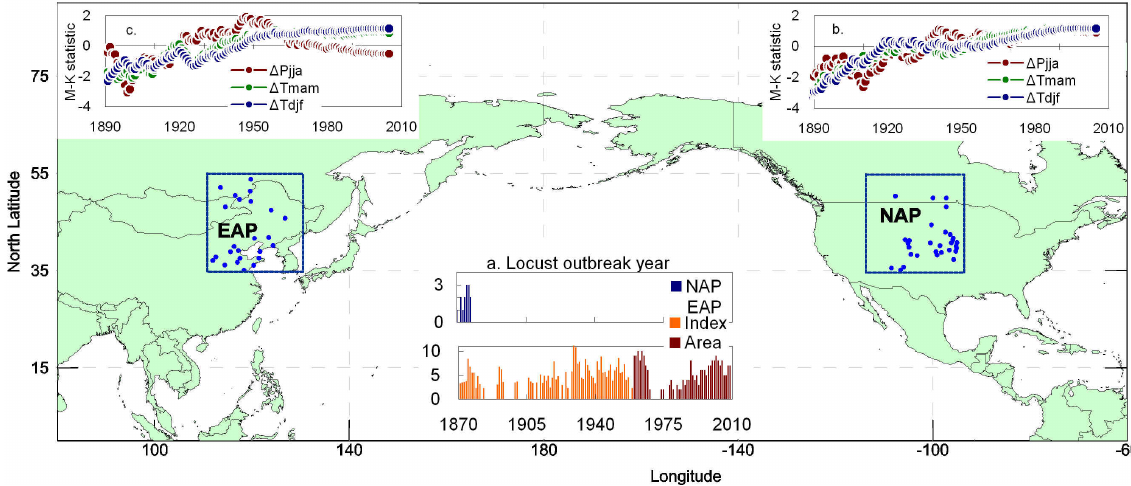
Fig. 1. Maps of study areas with location of meteorological stations, information of locust outbreaks (a) , climate changes in the North American Plains (NAP) (c) , and the Eastern Asian Plains (EAP) (b) . All abbreviations of climate variables are the same as used in the